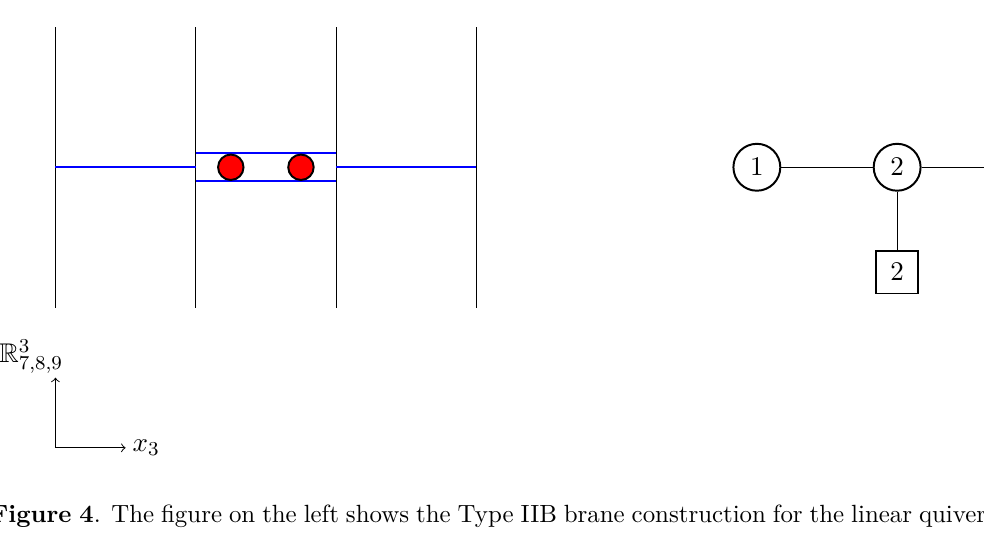
Figure 4 . The figure on the left shows the Type IIB brane construction for the linear quiver on the right. The red nodes represent D5 branes, the horizontal blue lines are D3 branes, and the vertical black lines represent NS5